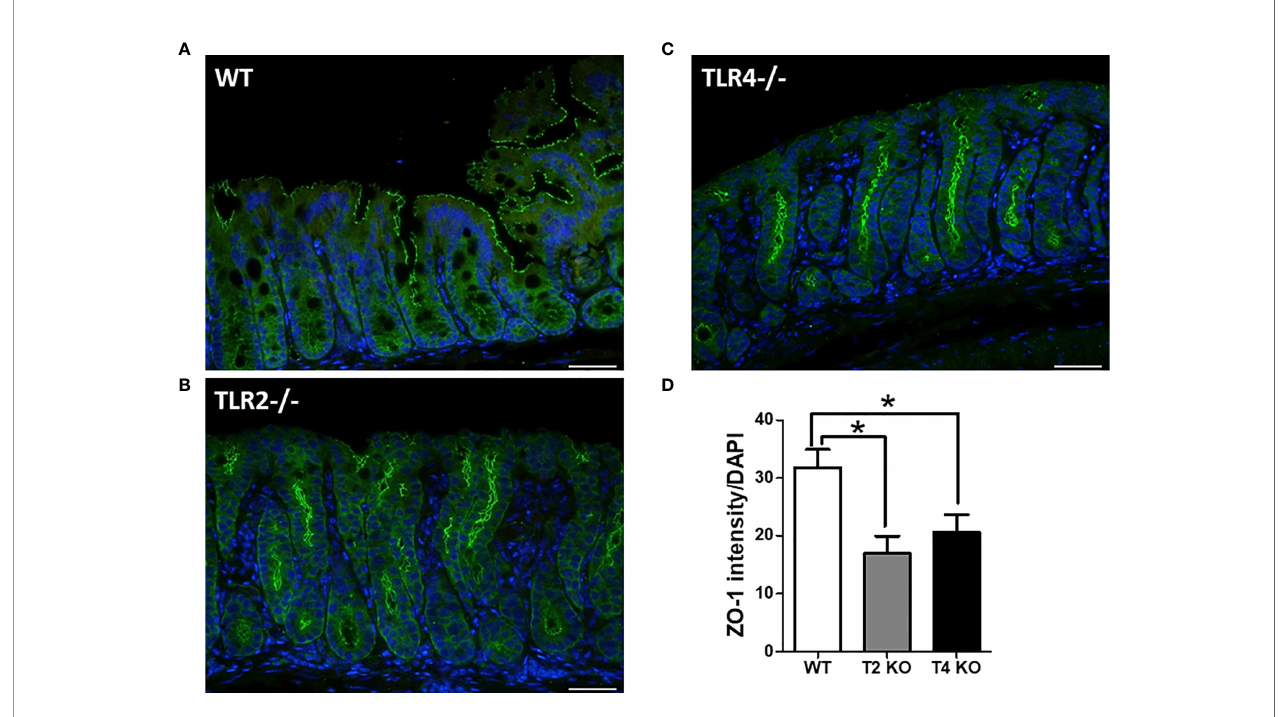
FIGURE 4 | Increased permeability and tight junction protein depletion in colonic epithelium of wild-type (WT, A ), Tlr2-/- (Tlr2 de fi ciency; B ) and Tlr4-/- (Tlr4 de fi ciency, C ) mice with CDI, as evidenced by immuno fl uorescent staining for ZO-1 (green) and Hoechst (blue). ZO-1 depletion was more evident in Tlr2-/- or Tlr4-/- mice than in wild-type (WT) mice (D) . Scale bar = 20 m m. (* P <